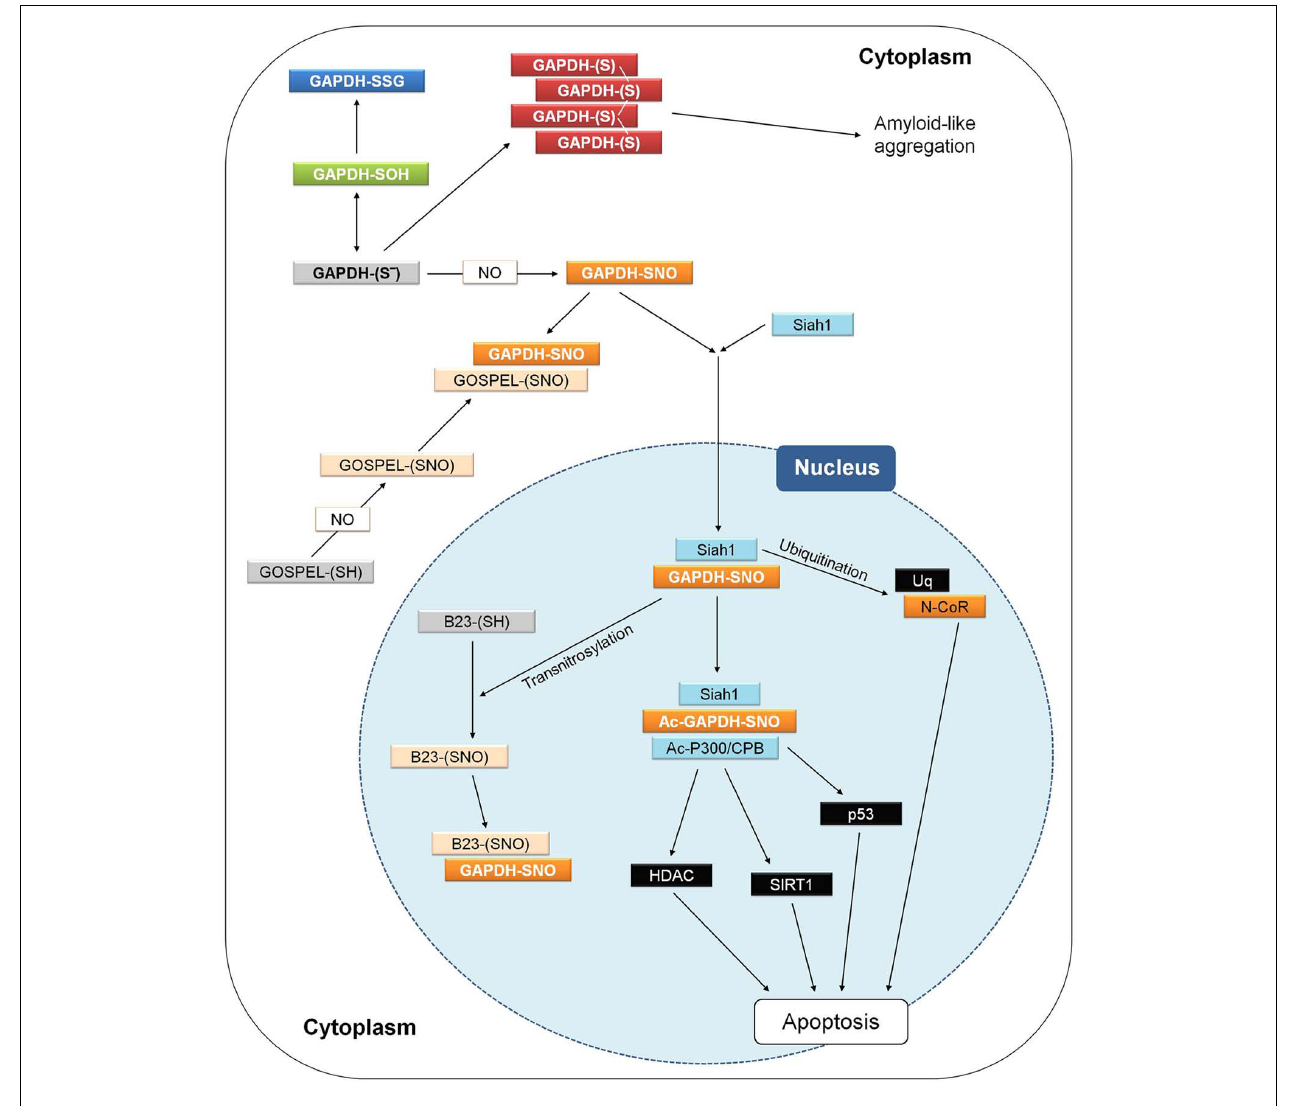
FIGURE 8 | GAPDH and apoptosis in animal cells. Interactions and processes that have been observed in different studies and cell types are here summarized in a single hypothetical animal cell. Different apoptotic stimuli may induce NO biosynthesis and the figure shows how apoptosis in animal cells may be triggered by the initial